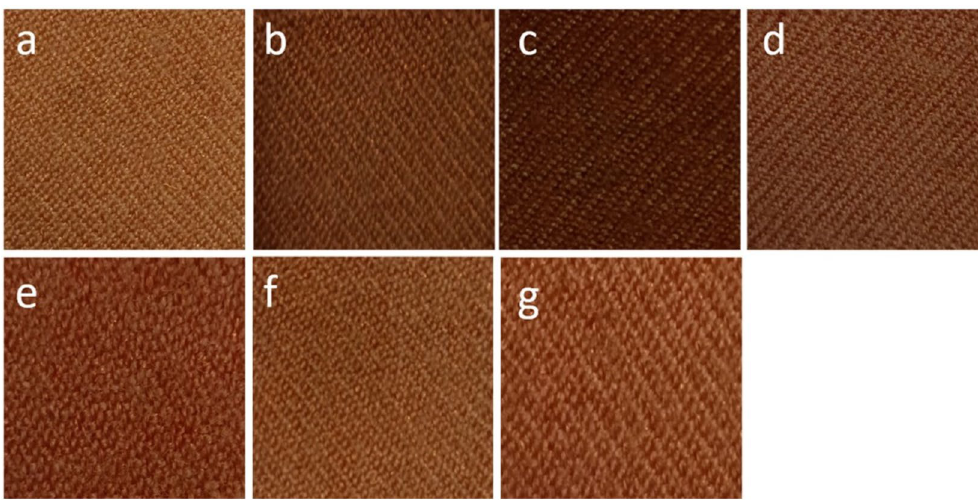
Figure 2. Wool fabrics dyed using ( a ) 2% RE without mordant, ( b ) 4% RE without mordant, ( c ) 6% RE without mordant, ( d ) 4% RE with Al 2 (SO 4 ) 3 , ( e ) 4% RE with P. granatum , ( f ) 4% RE with C. sinensis , ( g ) 4% RE with R. coriaria